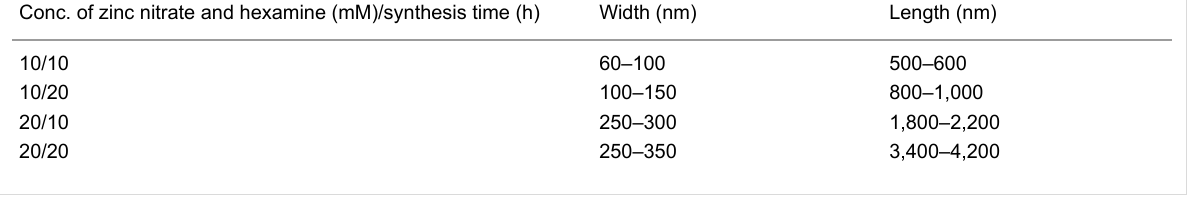
Table 1: Widths and lengths of ZnO nanorods grown at different concentrations of zinc nitrate and hexamine for different durations (50 nanorods sampled for each). Conc. of zinc nitrate and hexamine (mM)/synthesis time (h)